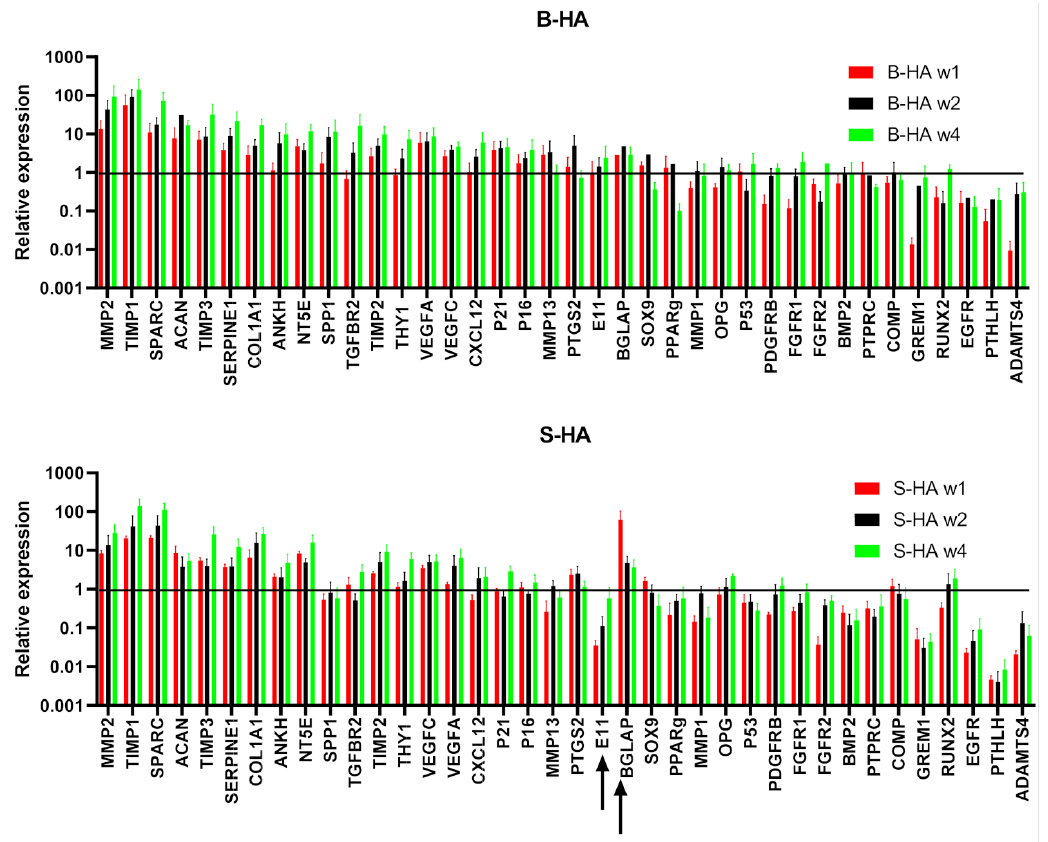
Figure 5. Gene expression of cMSCs normalised to HPRT. Top panel shows the gene expression of transcripts on B-HA, and the bottom panel shows gene expression of transcripts on S-HA for week 1, 2 and 4. Data were normalised to the housekeeping gene HPRT1 , indicated with the black horizontal line. Black arrows indicate genes that displayed expression levels lower than that of the housekeeping gene. Data are shown as mean with standard error of mean for n = 3